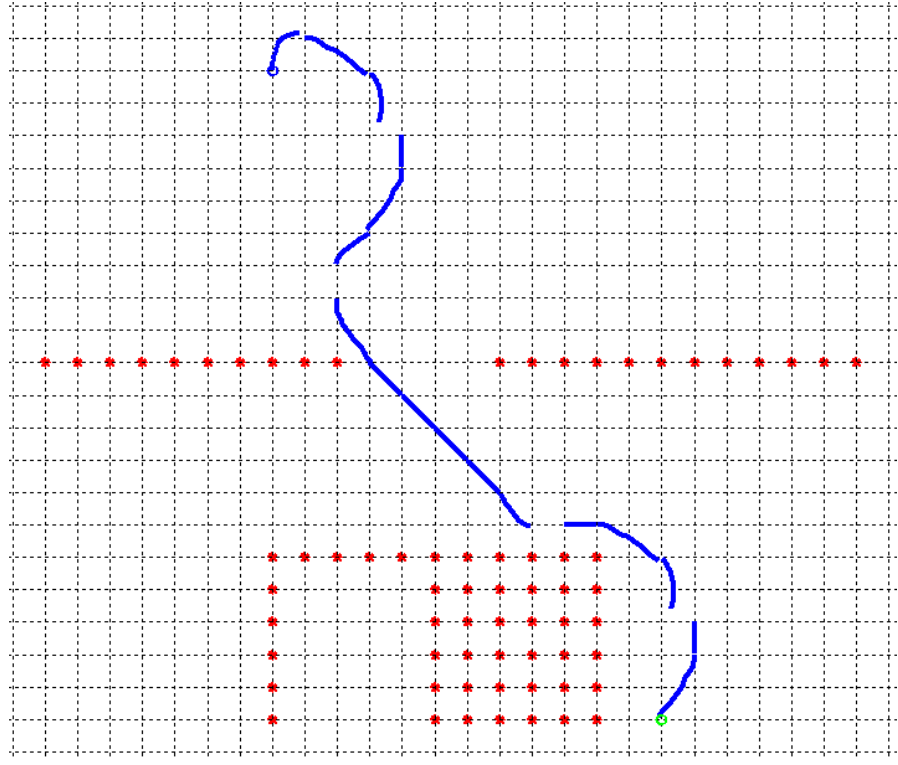
Figure 1. Motion planning algorithm without considering wind and current